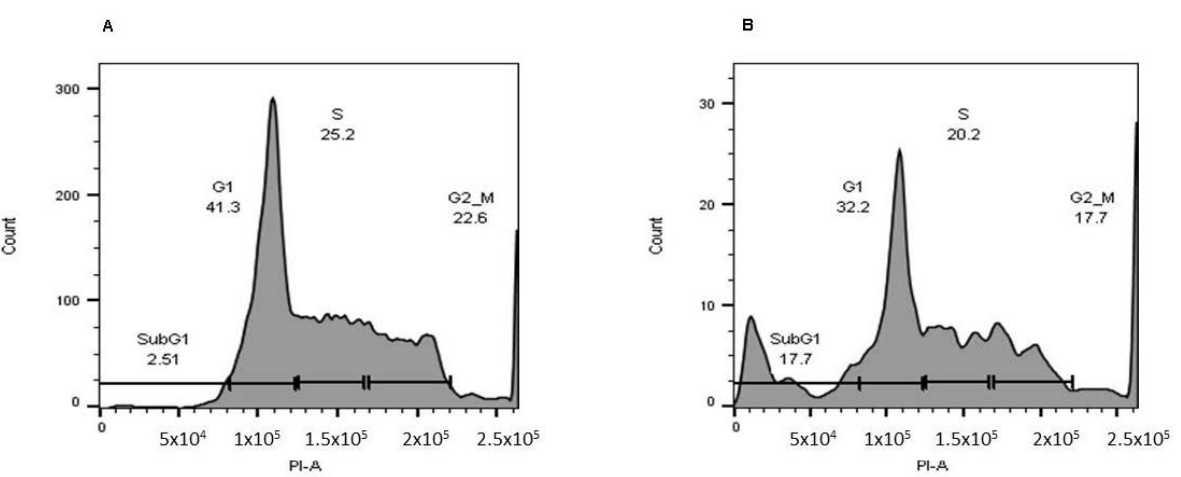
Figure 5. Carnosic acid induces cell cycle arrest in AGS cells. ( A ) AGS cells treated with DMSO (negative control) and ( B ) AGS cells treated with the carnosic acid (20 µg/mL) for 24 h. The cell-cycle analysis was performed using flow cytometry, and propidium was used to evaluate the DNA content.